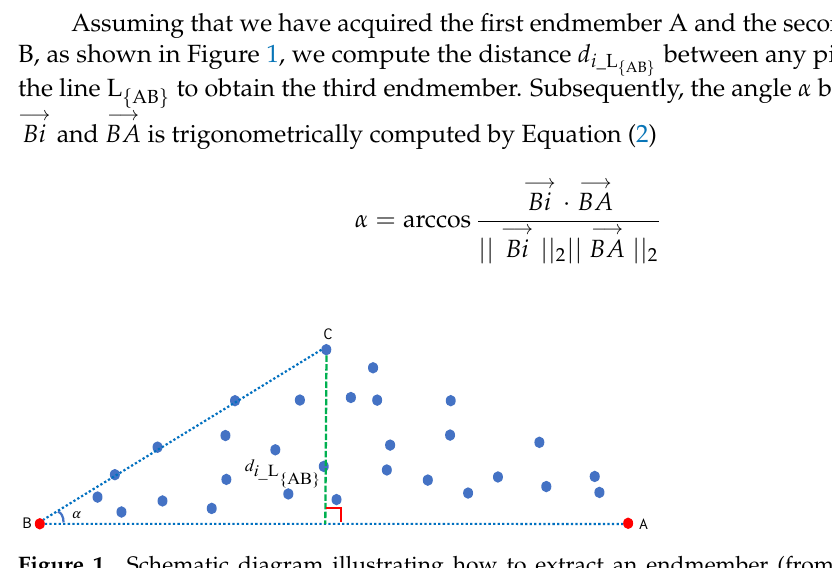
Figure 1. Schematic diagram illustrating how to extract an endmember (from two previously available ones) by using our maximum distance analysis (MDA) method. The farthest pixel point from the line L { AB } is the third endmember. The red dots represent endmembers that have been previously extracted, and the blue dots denote the pixel points in the pixel